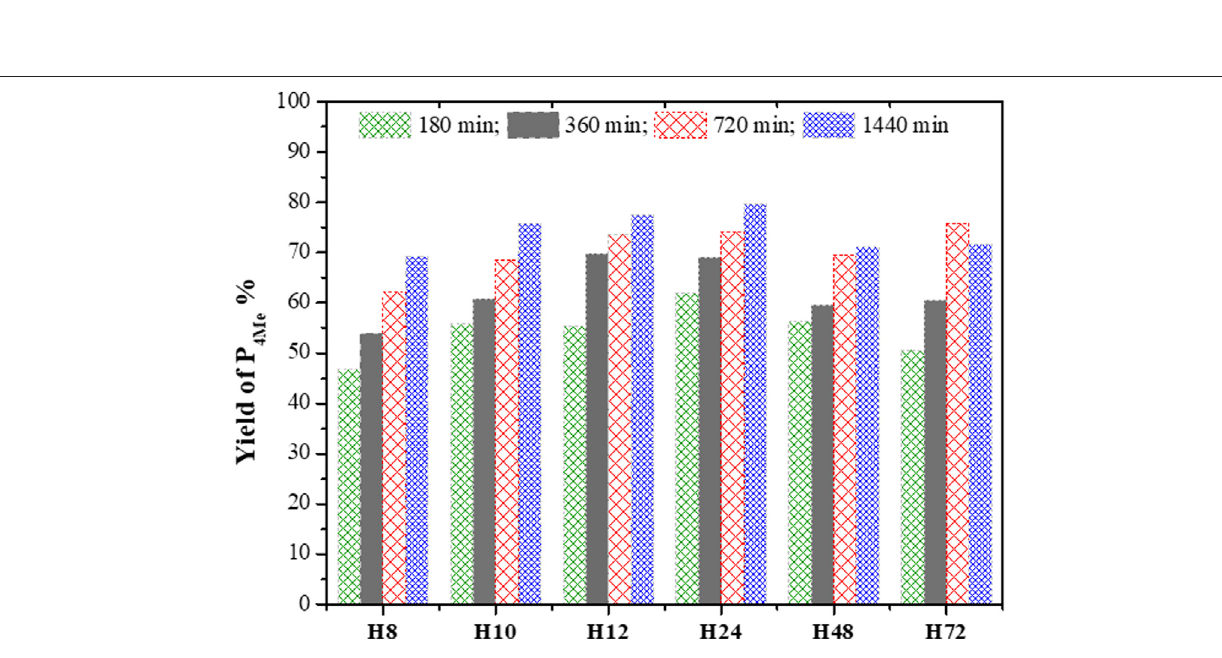
Frontiers in Chemistry |